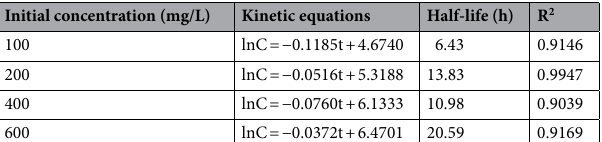
Initial concentration